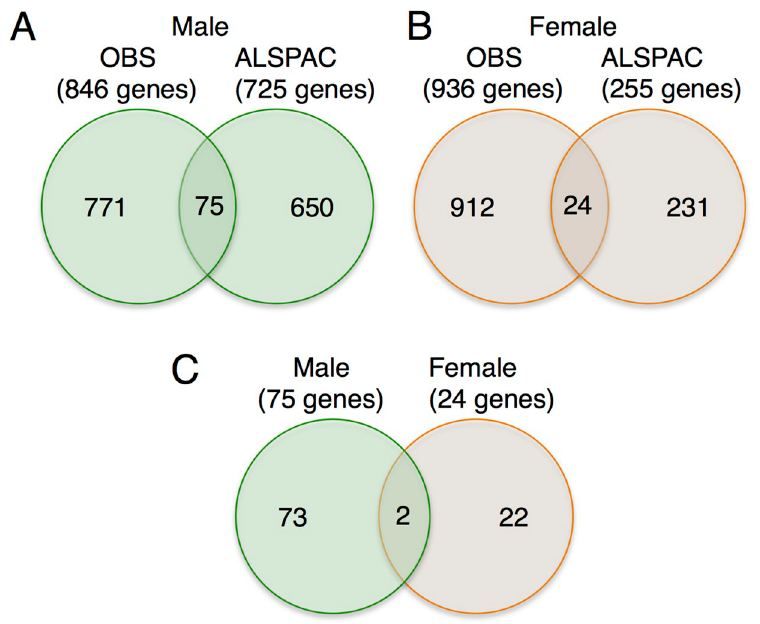
Fig 3. Annotation of differentially methylated regions for the OBS and ALSPAC cohorts. The numbers of genes associated with DMRs for (A) male and (B) female neonates. (C) The number of genes for each sex for genes that replicated across both cohorts. The total number of genes associated with DMRs for each sex are shown in